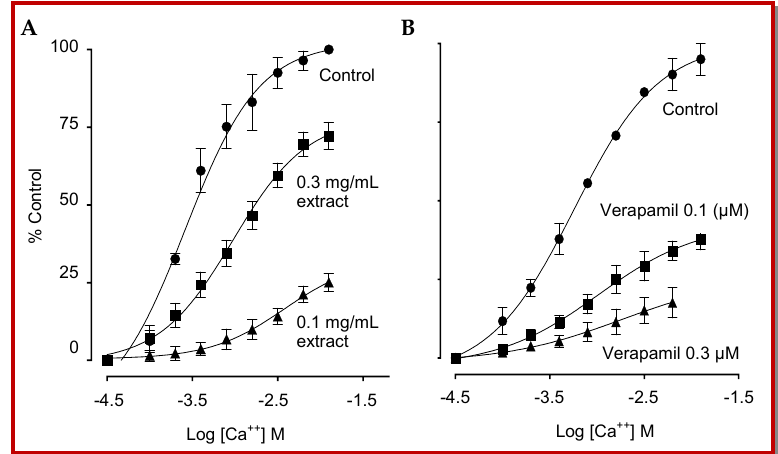
Figure 3: Concentration response curves of Ca ++ in the presence and absence of increasing concentration of crude extract (A) and verapamil (B) in the isolated rabbit jejunum preparations. Values are expressed as the mean ± SEM, n = 5